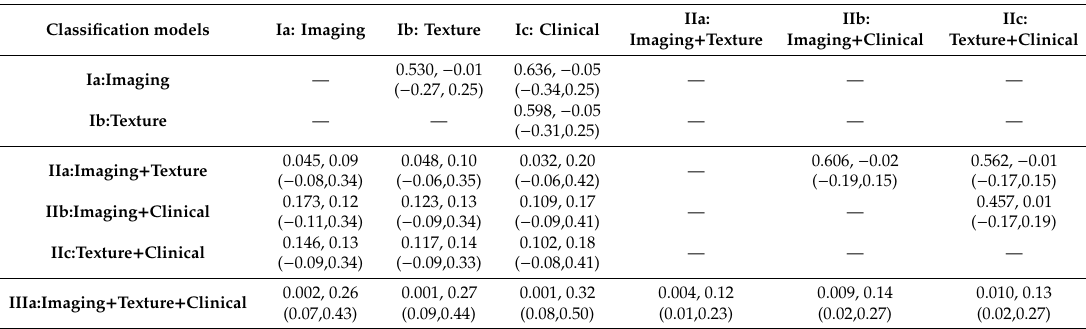
Table 3. Comparison of the performance of the models measured by di ff erence in the area-under- the-curve (AUCs) across 1000 permuted runs. Each entry in the table has p -value, average di ff erence of AUC of the models, and confidence interval of 1000 AUCs.